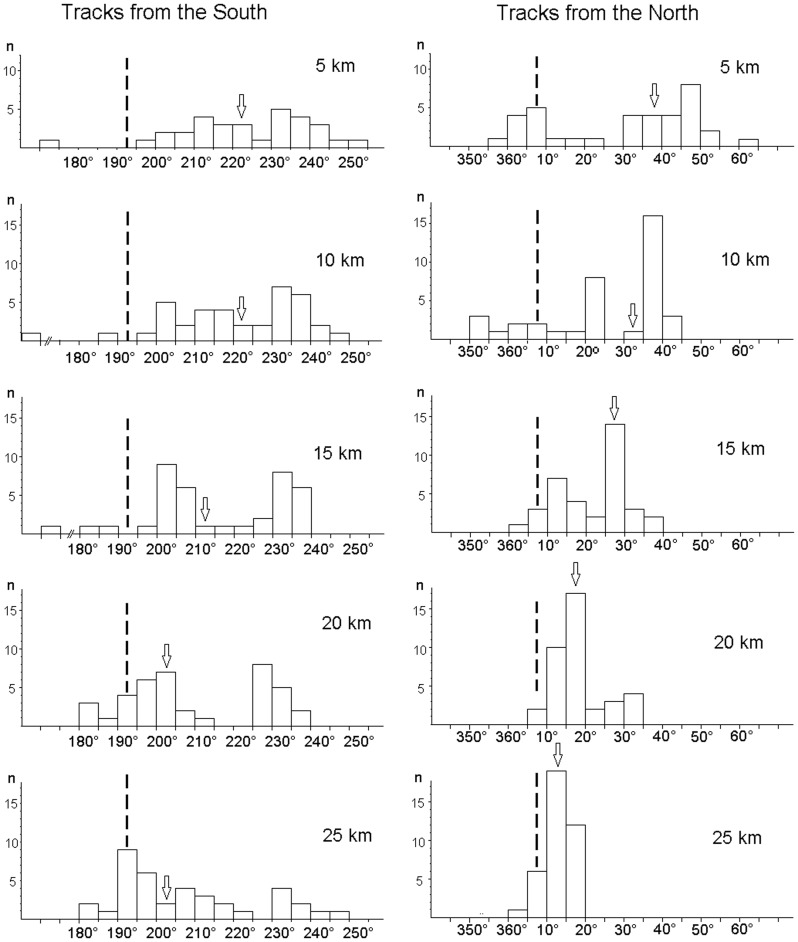
Distribution of bearings at the various distances from the loft; the bearing are given in 5° groups.The dashed line marks the home direction; the open arrow indicates the median of the distribution.